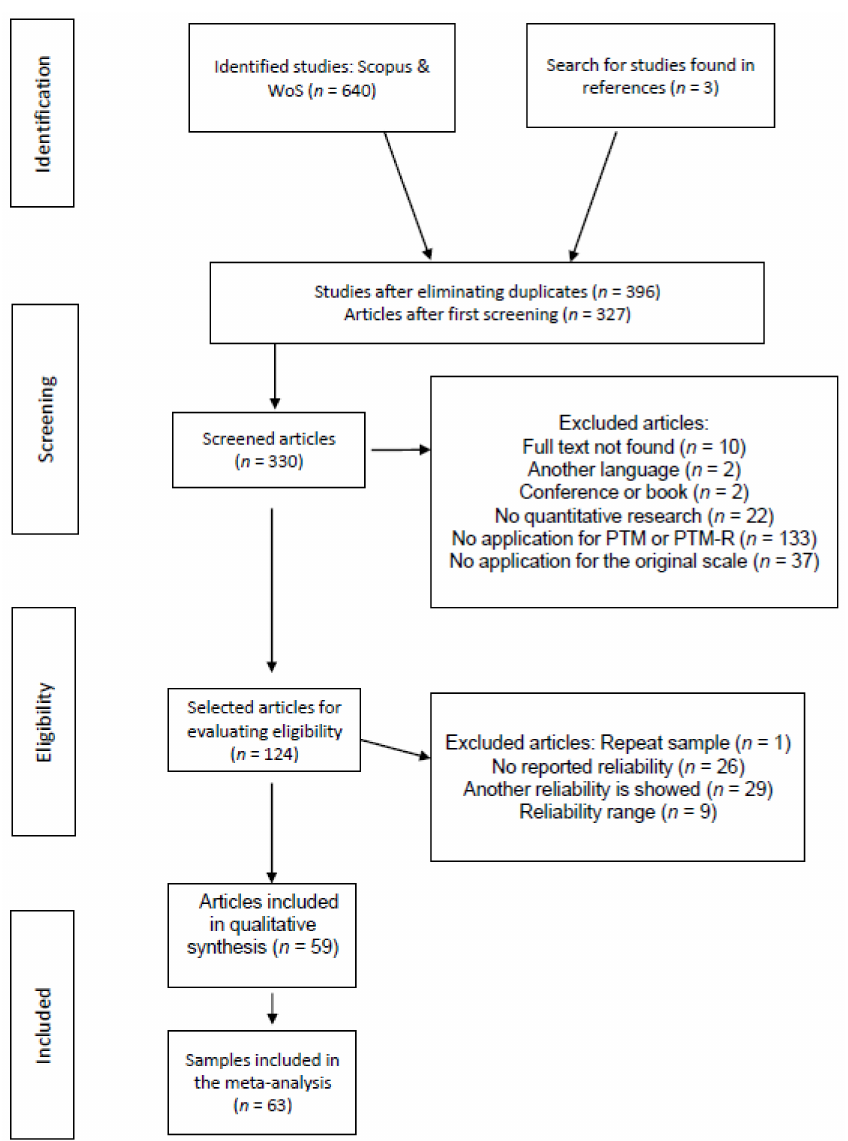
Figure 1. Flow chart of articles included in the